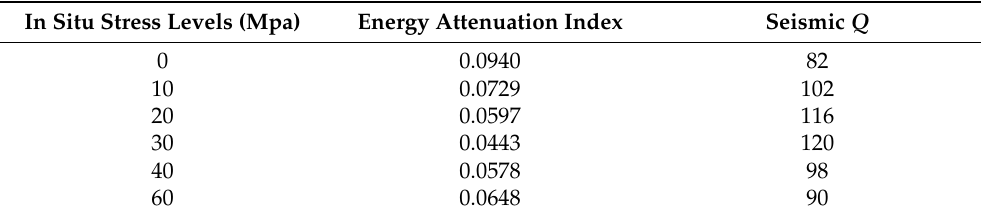
Table 2. Seismic energy attenuation indexes and seismic Q under varied hydrostatic in situ stress levels. In Situ Stress Levels